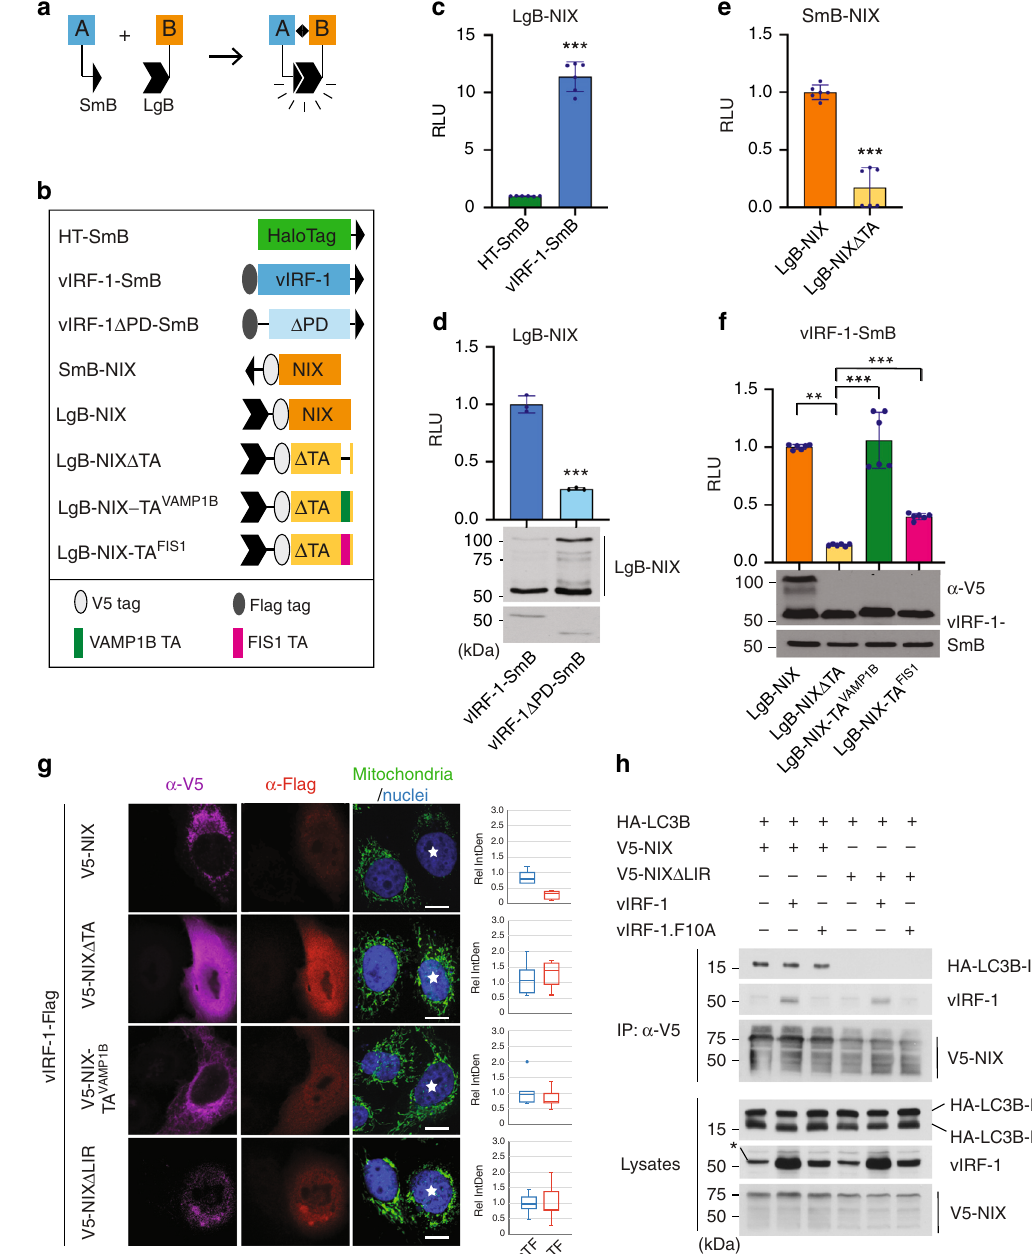
Fig. 5 Structural requirement of NIX for interaction with vIRF-1. a Principle of the NanoBiT-based protein fragment complementation assay (PCA). When a protein [A] binds to its partner [B], their fused Small BiT (SmB; 1.3 kDa) and Large BiT (LgB; 17.6 kDa) fragments are brought into proximity, which allows structural complementation thus yielding a functional enzyme acting on Nano luciferase substrate. b Schematic structure of the NanoBiT-fused proteins used in the following studies. TA indicates the tail-anchor domain. c – f NanoBiT PCA assays were performed using 293T cells transiently transfected with the indicated NanoBiT binary plasmids. Each value represents the mean of triplicate samples from two independent experiments. Error bars represent standard deviations. The p -values were determined by matched pair t -test (** p < 0.01 and *** p < 0.001) c The optimal orientation of vIRF-1 and NIX (vIRF-1- SmB and LgB-NIX) was compared to HaloTag (HT)-SmB and LgB-NIX fusion proteins (See also Supplementary Fig. 5). g IFA analysis of mitochondria content (TFAM) in HeLa.Kyoto cells that were transiently transfected for 24 h with vectors expressing vIRF-1-Flag and V5-NIX (wild type or variants, NIX- TA VAMP1B and NIX Δ LIR lacking the LC3-interacting region (LIR)). Double-transfected cells are marked with white stars. Relative IntDen was calculated by dividing by unTF control and is shown in a Box-Whisker diagram. Scale bar, 10 µ m. h Co-IP analysis of the effect of vIRF-1 on NIX interaction with LC3B. HeLa.Kyoto cells transiently transfected with vectors expressing HA-LC3B and V5-NIX wild type or mutant (NIX Δ LIR) in the presence or absence of vIRF-1 wild type and F10A mutant. Cells were treated overnight with ba fi lomycin A1 before their harvest. Asterisk indicates a non-speci fi c band. Source data are provided as a Source Data fi